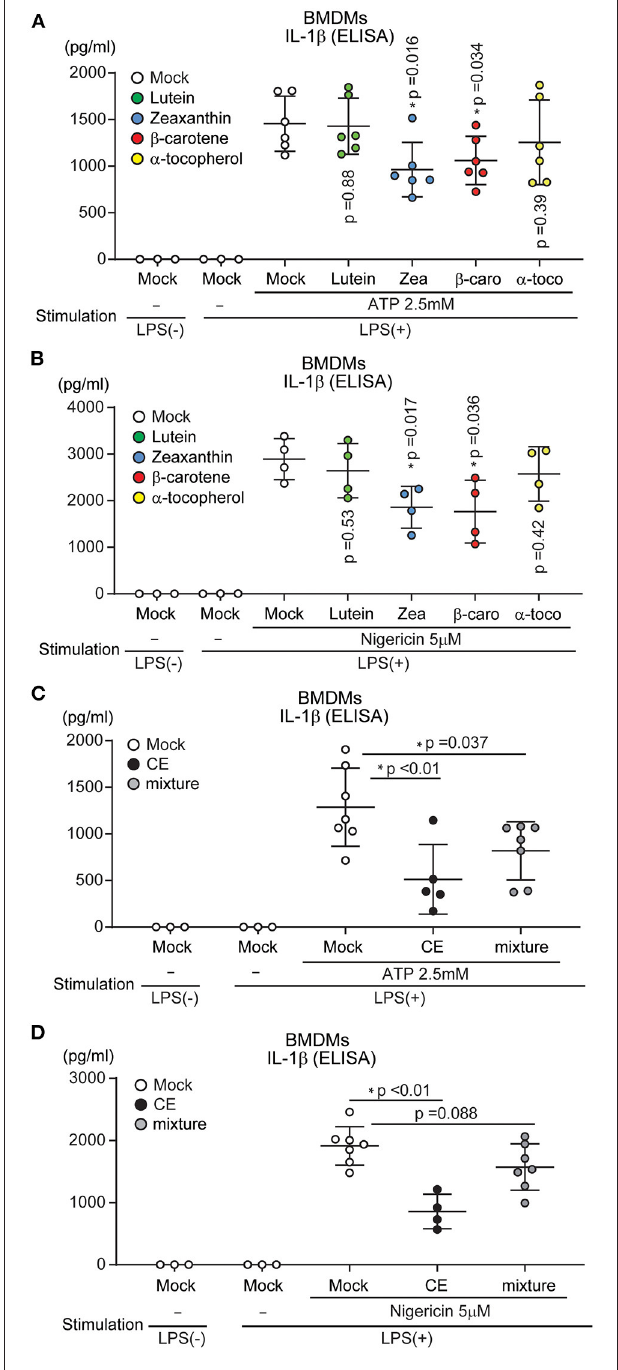
FIGURE 6 | The effect of each component of Chlorella extract on IL-1 β secretion. (A–D) BMDMs were treated with Mock, CE, 1.5 µ M Carotenoids (Lutein, zeaxanthin: Zea, β -carotene: β -caro), α -tocopherol ( α -toco) and mixture (1.5 µ M lutein, 0.12 µ M Zea, 0.91 µ M β -caro, and 0.16 µ M α -toco) for 16h prior to the addition of 10ng/mL for 4h before stimulation with ATP or nigericin for 30min. The levels of IL-1 β in cell culture supernatants were analyzed by ELISA. Error bar show mean ± SEM. * p < 0.05 vs. Mock-treated groups. Data are representative of at least three independent